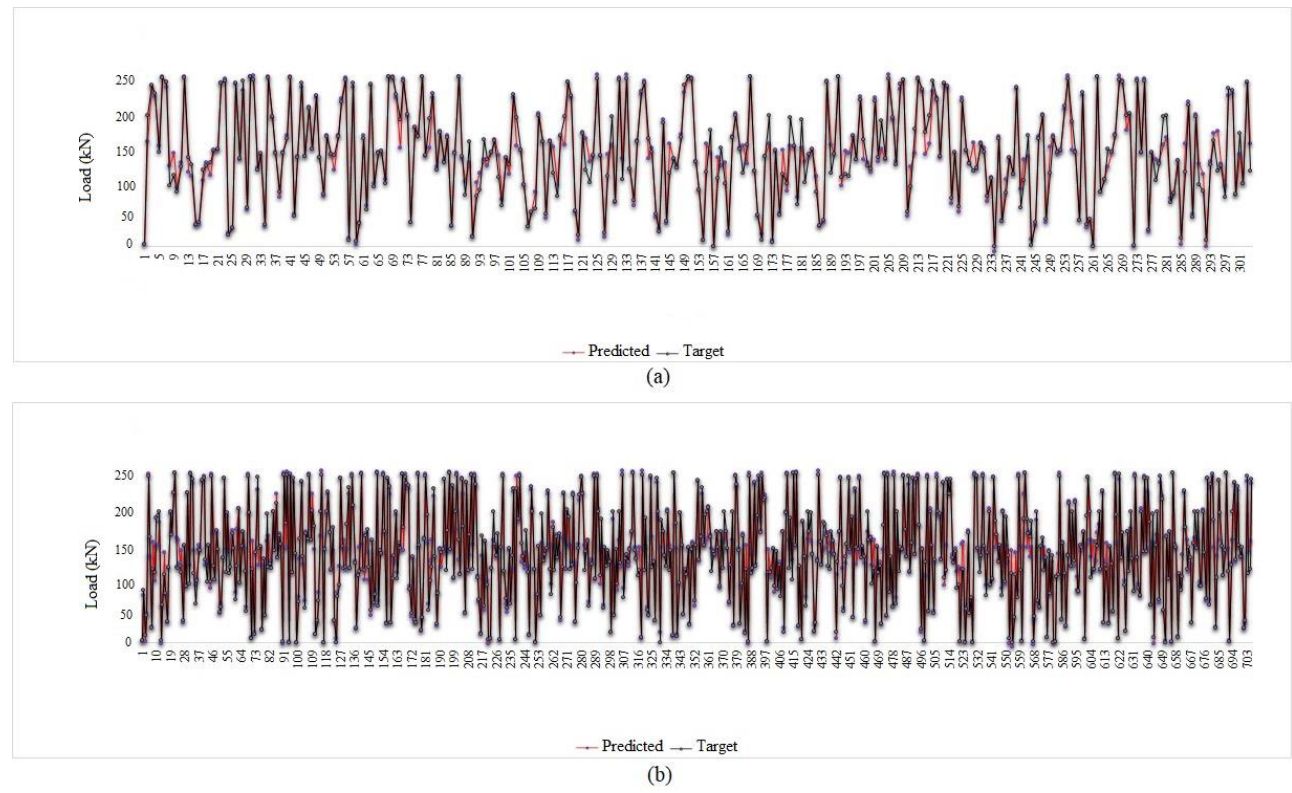
Figure 25. Tolerance diagram with respect to the MPF (four inputs) prediction: ( a ) test phase, ( b ) train phase.